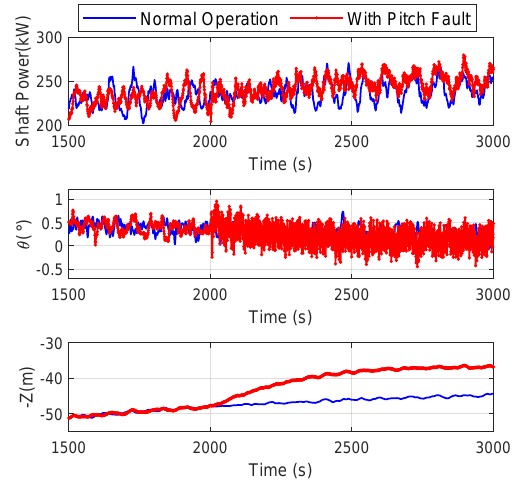
Fig. 5. Time histories of the OCT’s equilibrium states, i.e., angular speed ω , pitch angle θ , and vertical position Z before and after rotor stop at Time = 3000 .